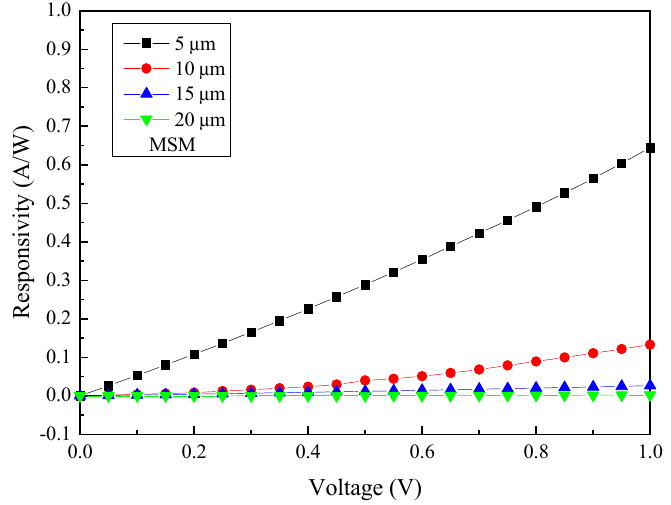
Figure 7. The responsivity of GeSn MSM PD at different four sizes under 2000 nm illumination.